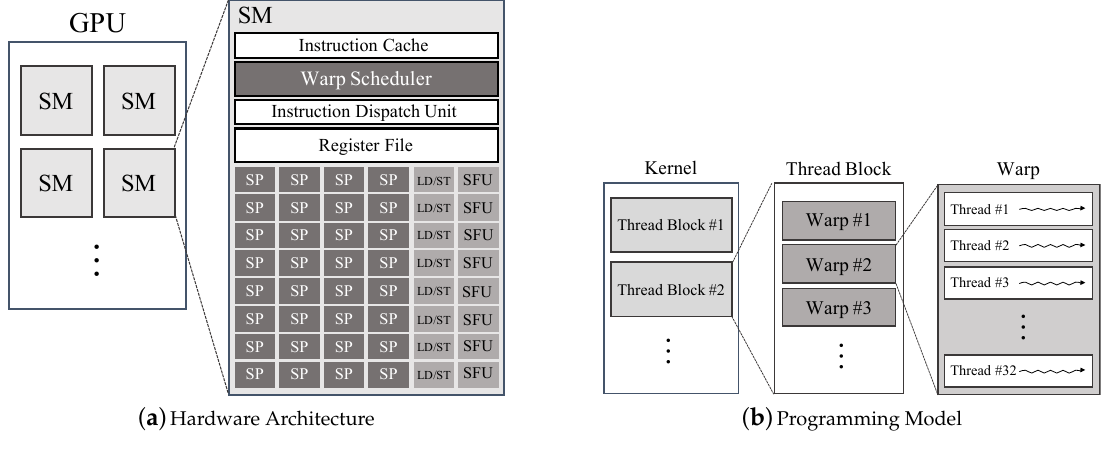
Figure 1. GPU hardware architecture and programming